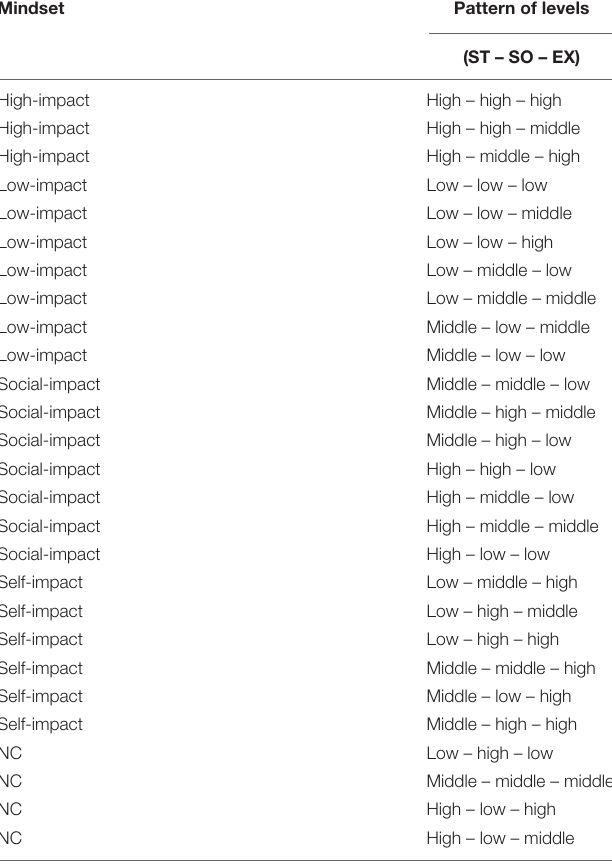
TABLE 5 | Mindset allocation.